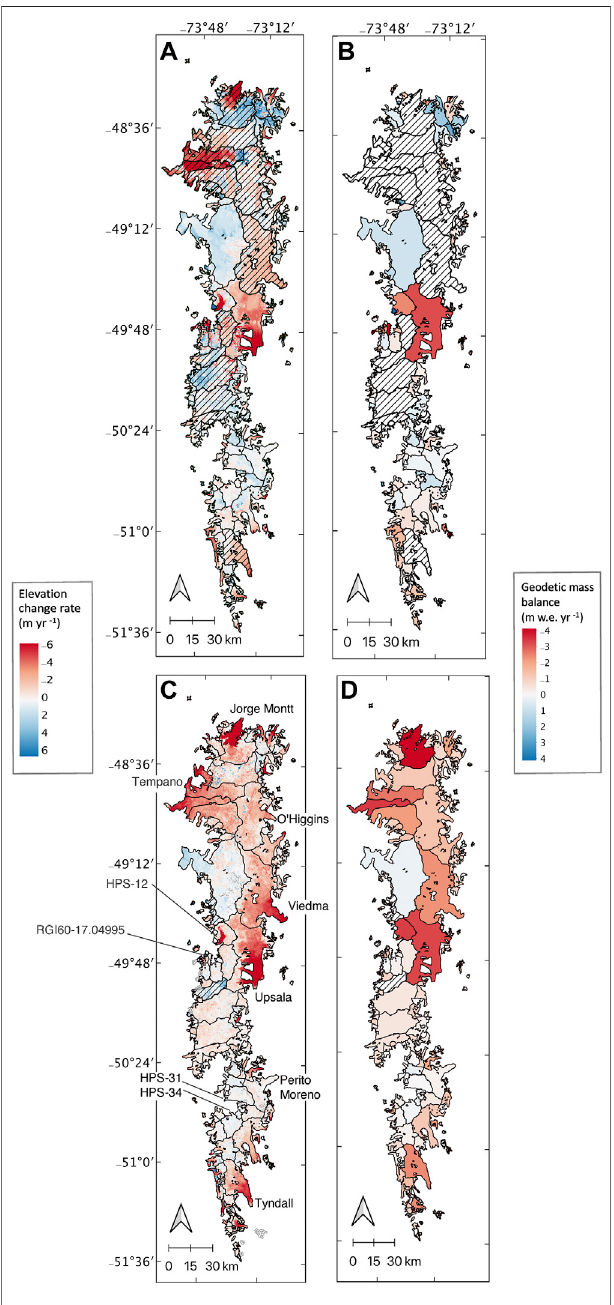
FIGURE 4 | Elevation change observed on the SPI in (A) 1976/1979 – 2000 and (C) 2000 – 2020.Hatchedglaciersarethosewithlessthan50%datacoverage. Glacieroutlinesarerepresentativeoftheir2000extent.Glaciersshadedgrayin (C) have no geodetic mass balance estimate. This elevation change integrated over the glacier surfaces results in geodetic mass balance for (B) the historical period and (D) the modern period. The geodetic mass balance color range presented does not represent the full range of data. To see all data points for the ice fi elds, see Supplementary Figures S4, S5 .